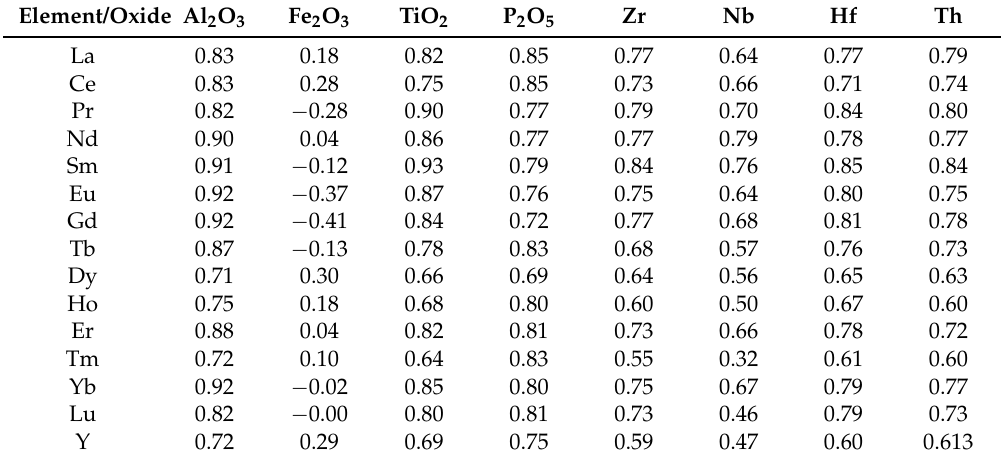
Table 7. Correlation coefficients of REEs and some major and trace elements of the Dopolan bauxite deposit.